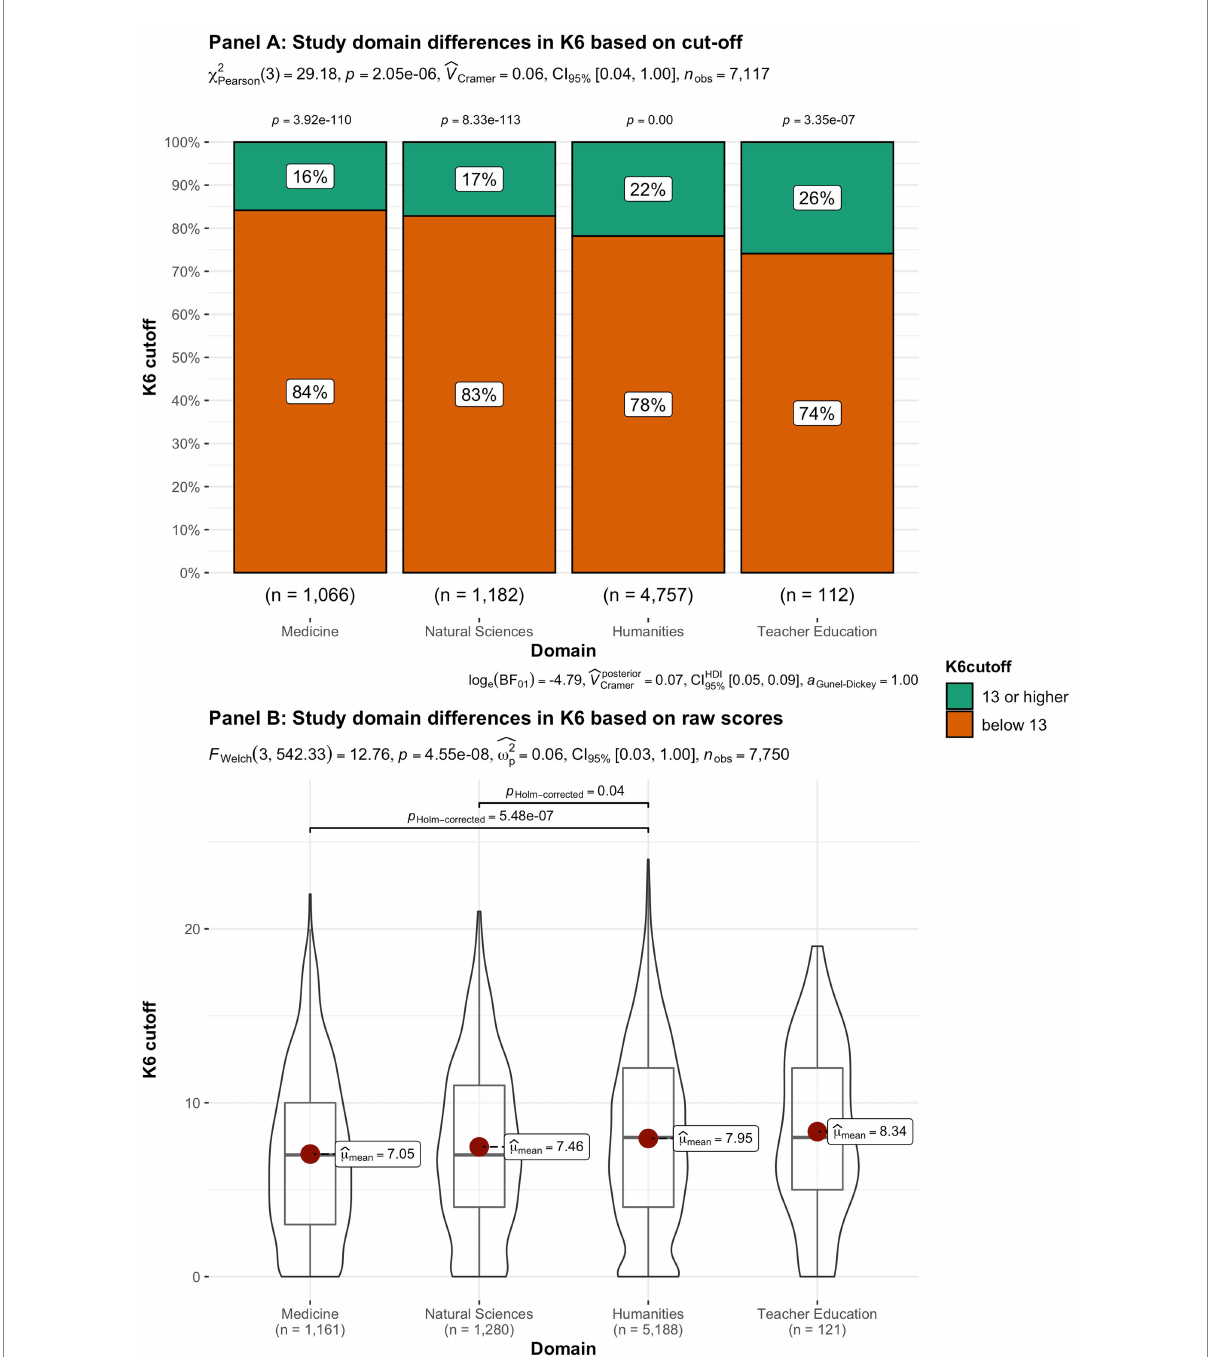
FIGURE 14 Summated scores on the K6 (indicator of mental illness and considered as a cutoff variable) across student subgroups in terms of study